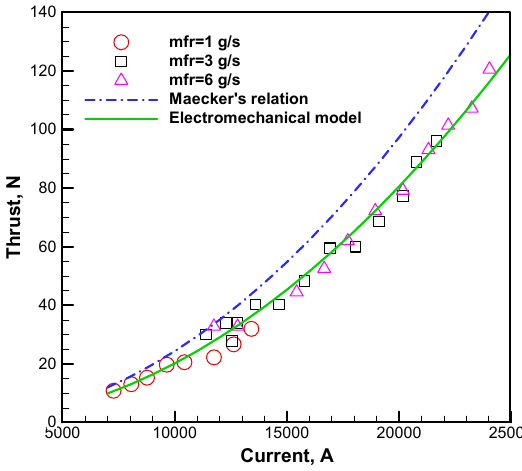
Figure 3. Variations of theoretical and experimental thrust with currents.